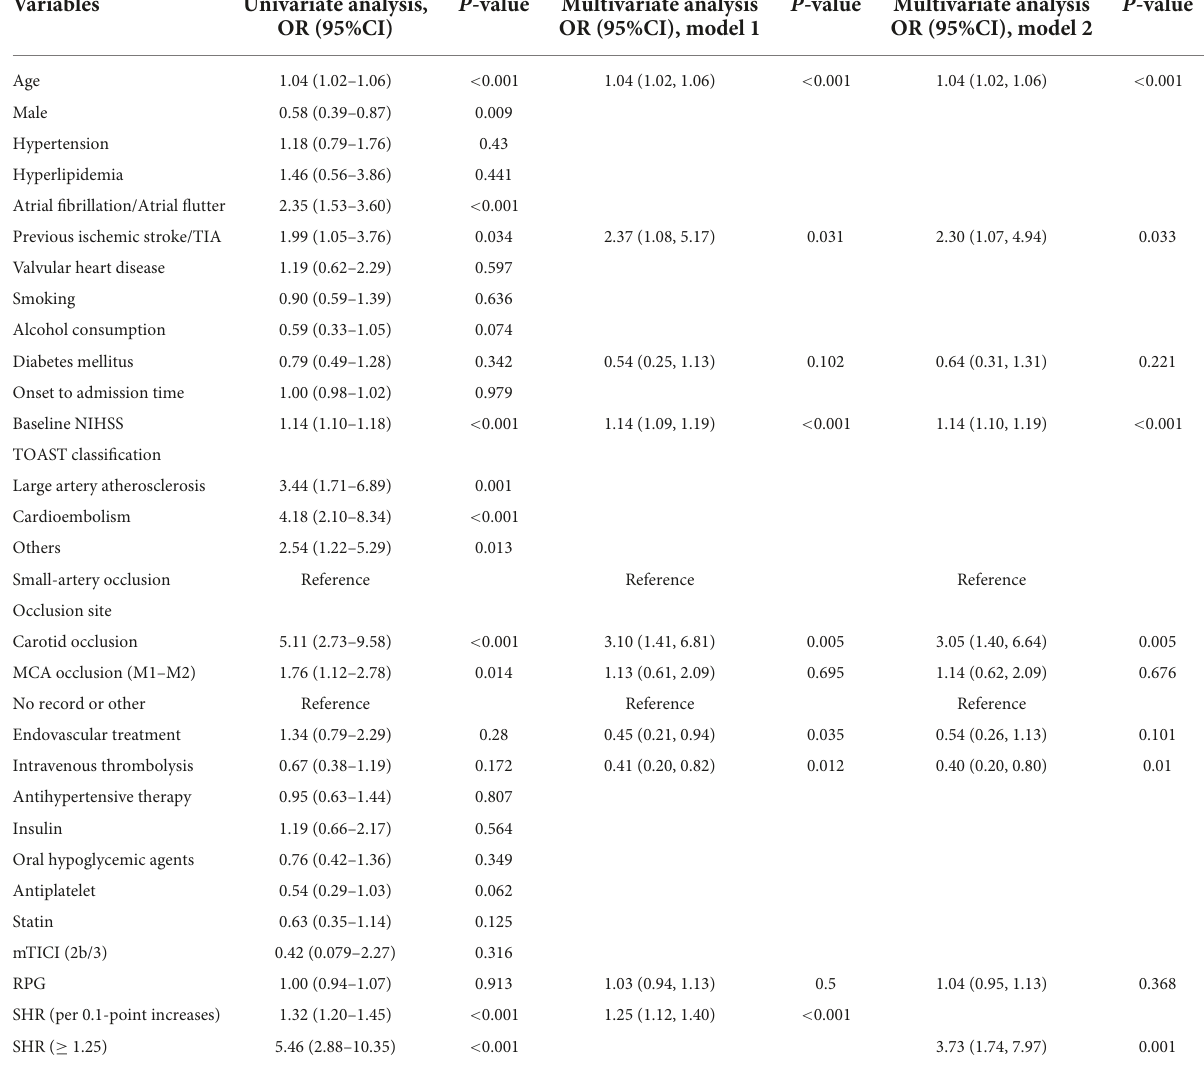
TABLE 3 Predictive factors for the development of 90-day poor outcome (mRS > 2) on training dataset.